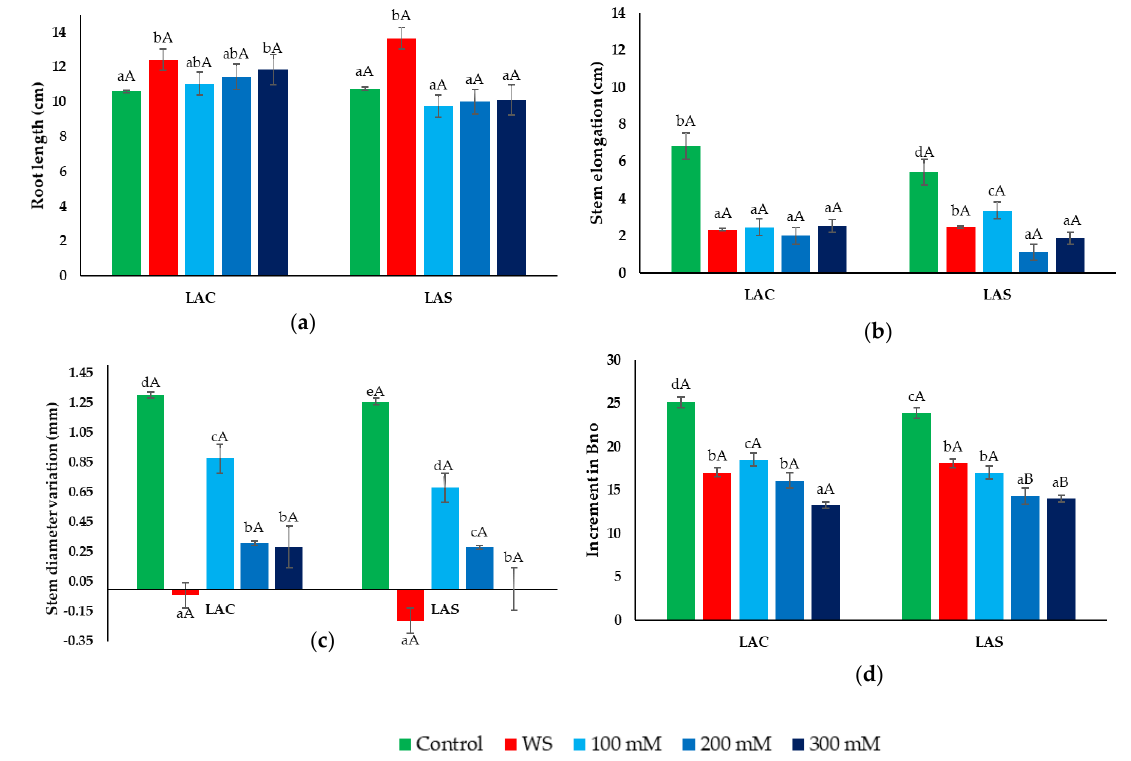
Figure 2. E ff ect of water and salt stress treatments on growth parameters in L. angustifolia var. ‘Codreanca’ (LAC) and var. ‘Sevtopolis’ (LAS). Root length (RL) ( a ); stem elongation (SE) ( b ); increase in stem diameter (SD) ( c ); increment in the number of branches (Bno) ( d ) in lavender plants after 30 days of growth under control conditions, in the presence of the indicated NaCl concentrations or subjected to water stress (WS) (completely withholding irrigation). Stem length, stem diameter, and number of branches were measured in all plants just before starting the treatments (time 0), and before collecting the samples (time 30). Bars represent means ± SE ( n = 5). Di ff erent lowercase letters above the bars indicate significant di ff erences between treatments for each variety, and di ff erent uppercase letters indicate significant di ff erences between the two varieties for plants undergoing the same treatment, according to the Tukey test ( α = 0.05).